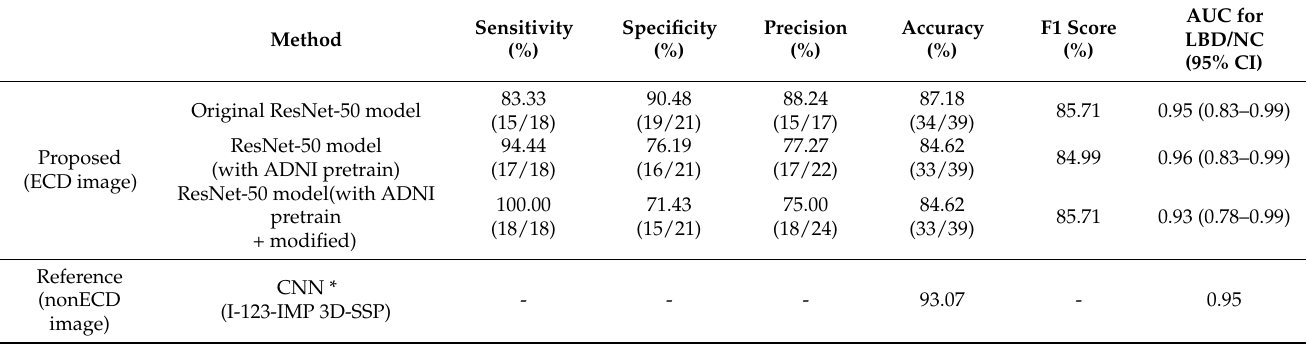
Table 5. Comparison of the training performance of ECD data sets in various models for distinguishing between LBD and NC.